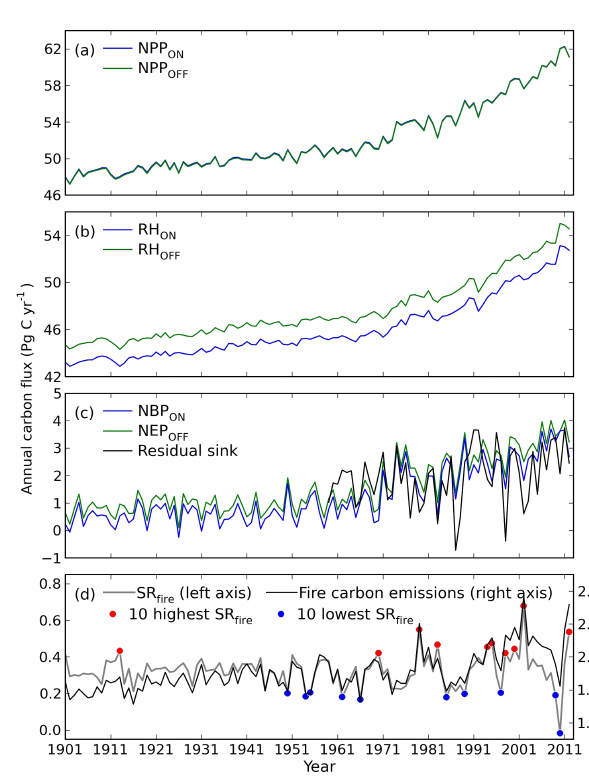
Figure 9. Different components of global carbon fluxes for fireON and fireOFF simulations. The carbon fluxes are (a) NPP; (b) het- erotrophic respiration (RH); (c) NBP and the residual land sink as reported by Le Quéré et al. (2013); and (d) the NBP reduction by fires (SR fire = NBP OFF − NBP ON , in grey, left vertical axis) and fire carbon emissions (black, right vertical